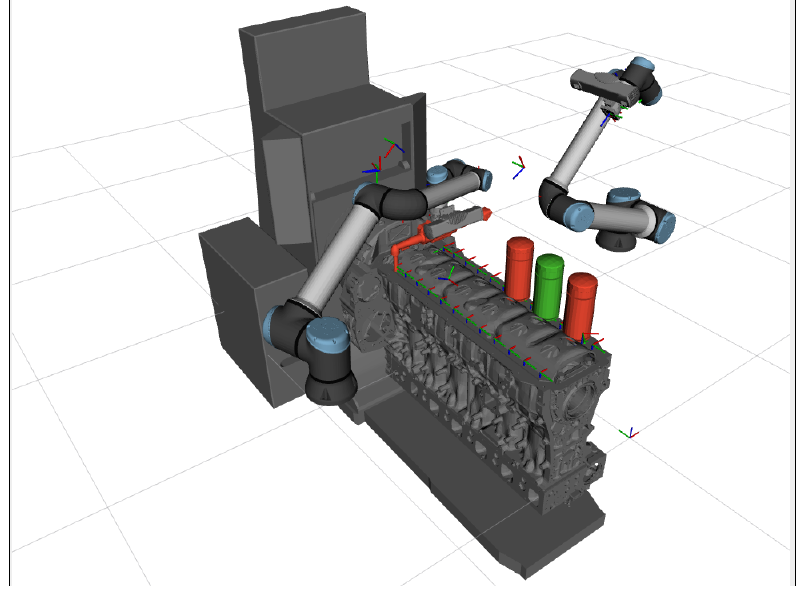
Figure 7. Simulation showing experiment E7. In this experiment, the robot to the left, r2 , has stopped responding for an unknown reason. However, it is still attached to the smart tool (orange), which is needed to complete assembly. Additionally, r2 is physically blocking the space around the